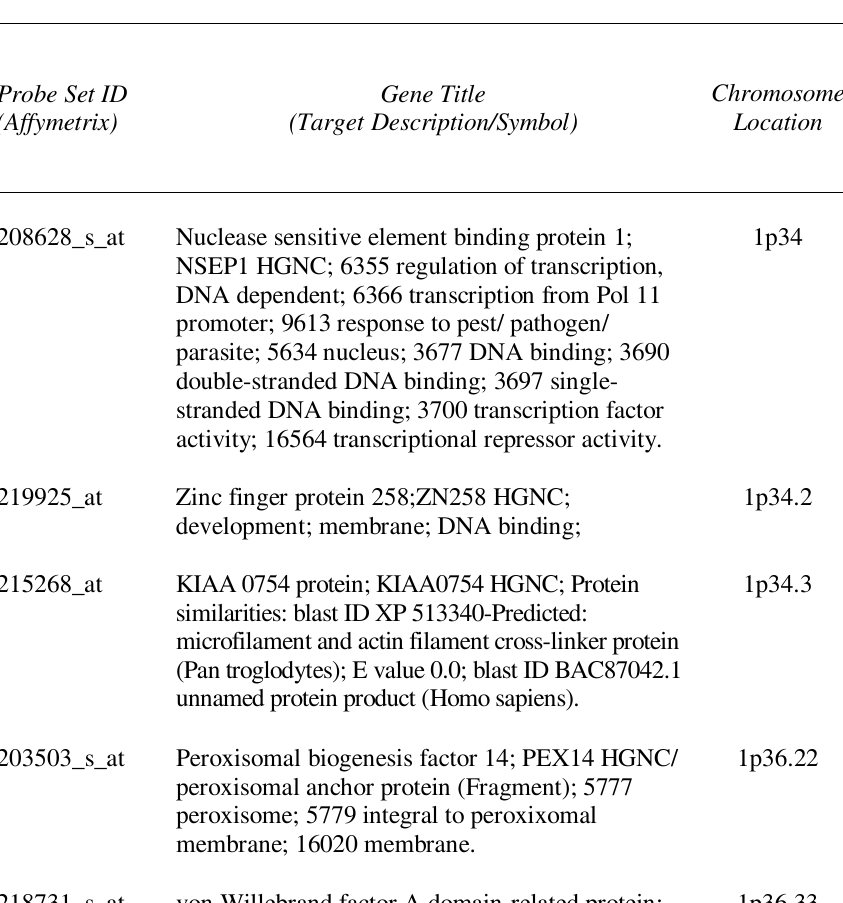
Table 1 contd.: Sample genes affected by mercury.